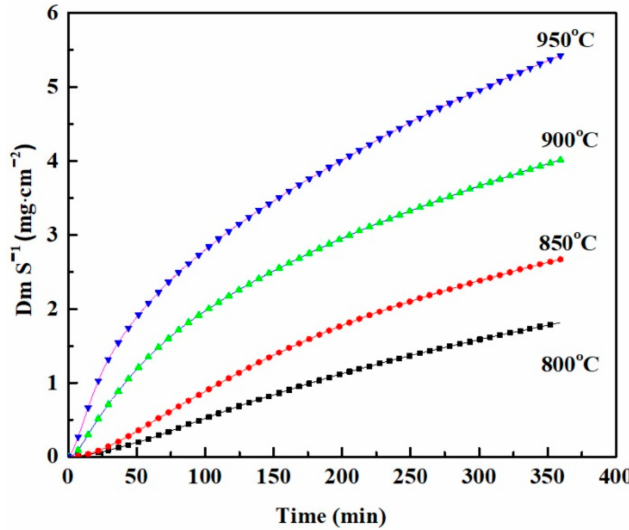
Figure 8. Mass gain graph of the Al coated samples, after isothermal oxidation at 800, 850, 900, 950 ◦ C. In Figure 9 the diagrams of the mass gain vs. t 0.5 are presented and it is equally revealed that, ignoring the first time-limited step of oxidation, the remaining phenomenon follows the parabolic law of Equation (7) as a result of ion diffusion.